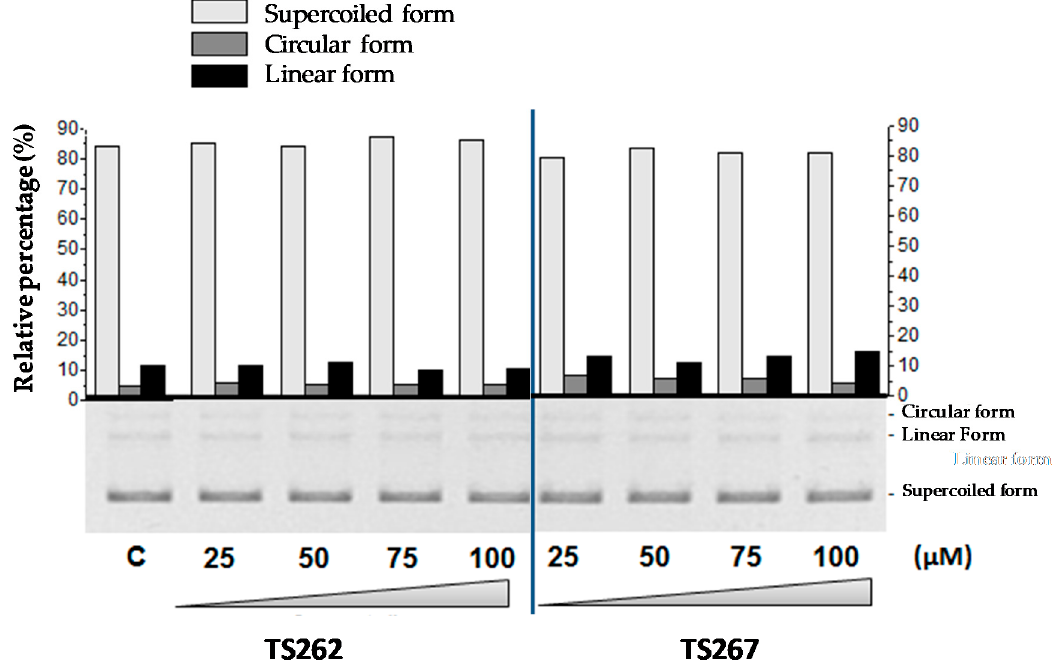
Figure 4. Electrophoretic evaluation of DNA double-strand cleavage by both Zn (II) phendione compounds (TS262 and TS267). Bottom: electrophoretic distribution of the three plasmid forms in an agarose gel (0.7%; w / v ) as a result of exposure to 25–100 µ M of the compounds. All reactions were conducted in 5 mM Tris-HCl and 50 mM NaCl (pH 7.02) for 24 h at 37 ◦ C. Plasmid DNA pBluescript II SK( + ) (pBSKII): (C) untreated. Top: densitometric quantification of plasmid forms using the image analysis software GelAnalyzer 2010a. Light grey bars represent the supercoiled form of plasmid DNA (pDNA), dark grey bars the circular form of pDNA, and black bars the linear form of pDNA. Results are expressed as mean ± SD of three independent experiments.